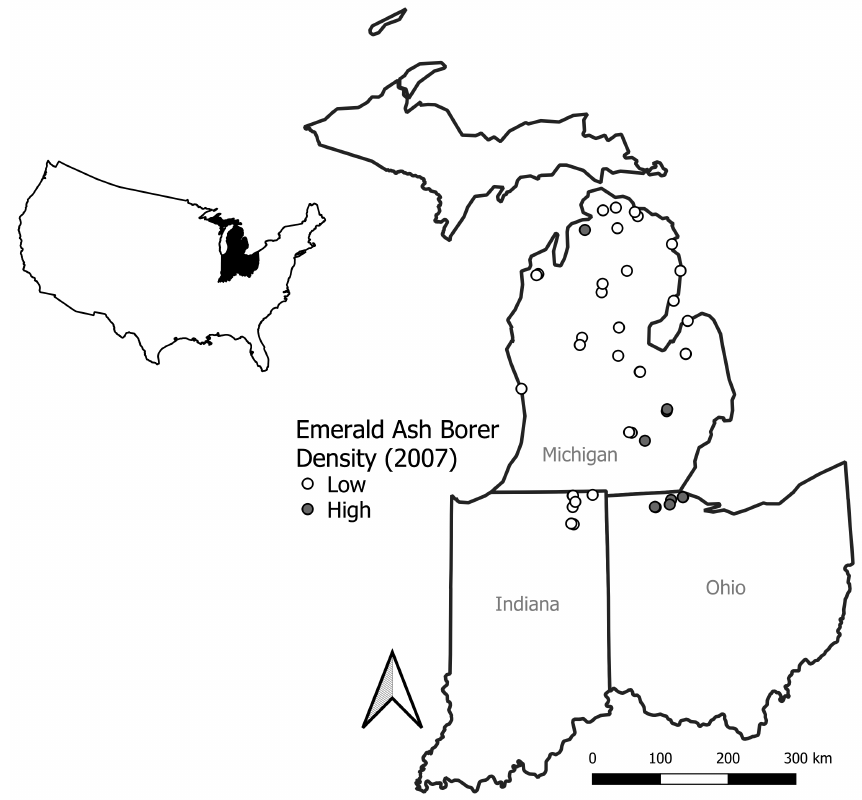
Figure 1. Survey locations in Indiana, Michigan, and Ohio. Emerald ash borer density in 2007 from